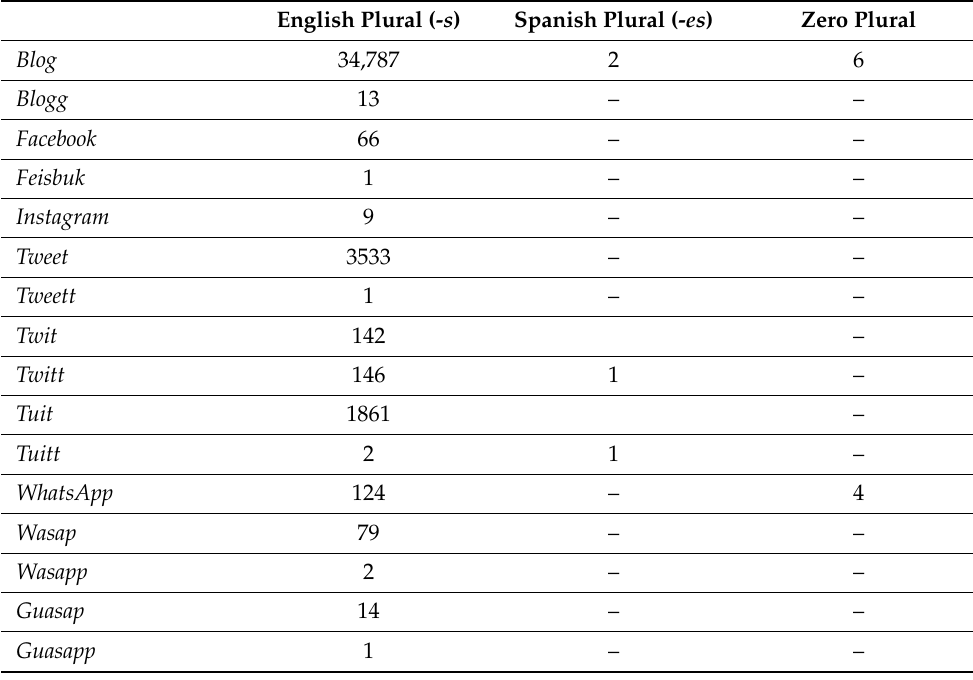
Table 3. Number of pluralization patterns attested in our corpus-based